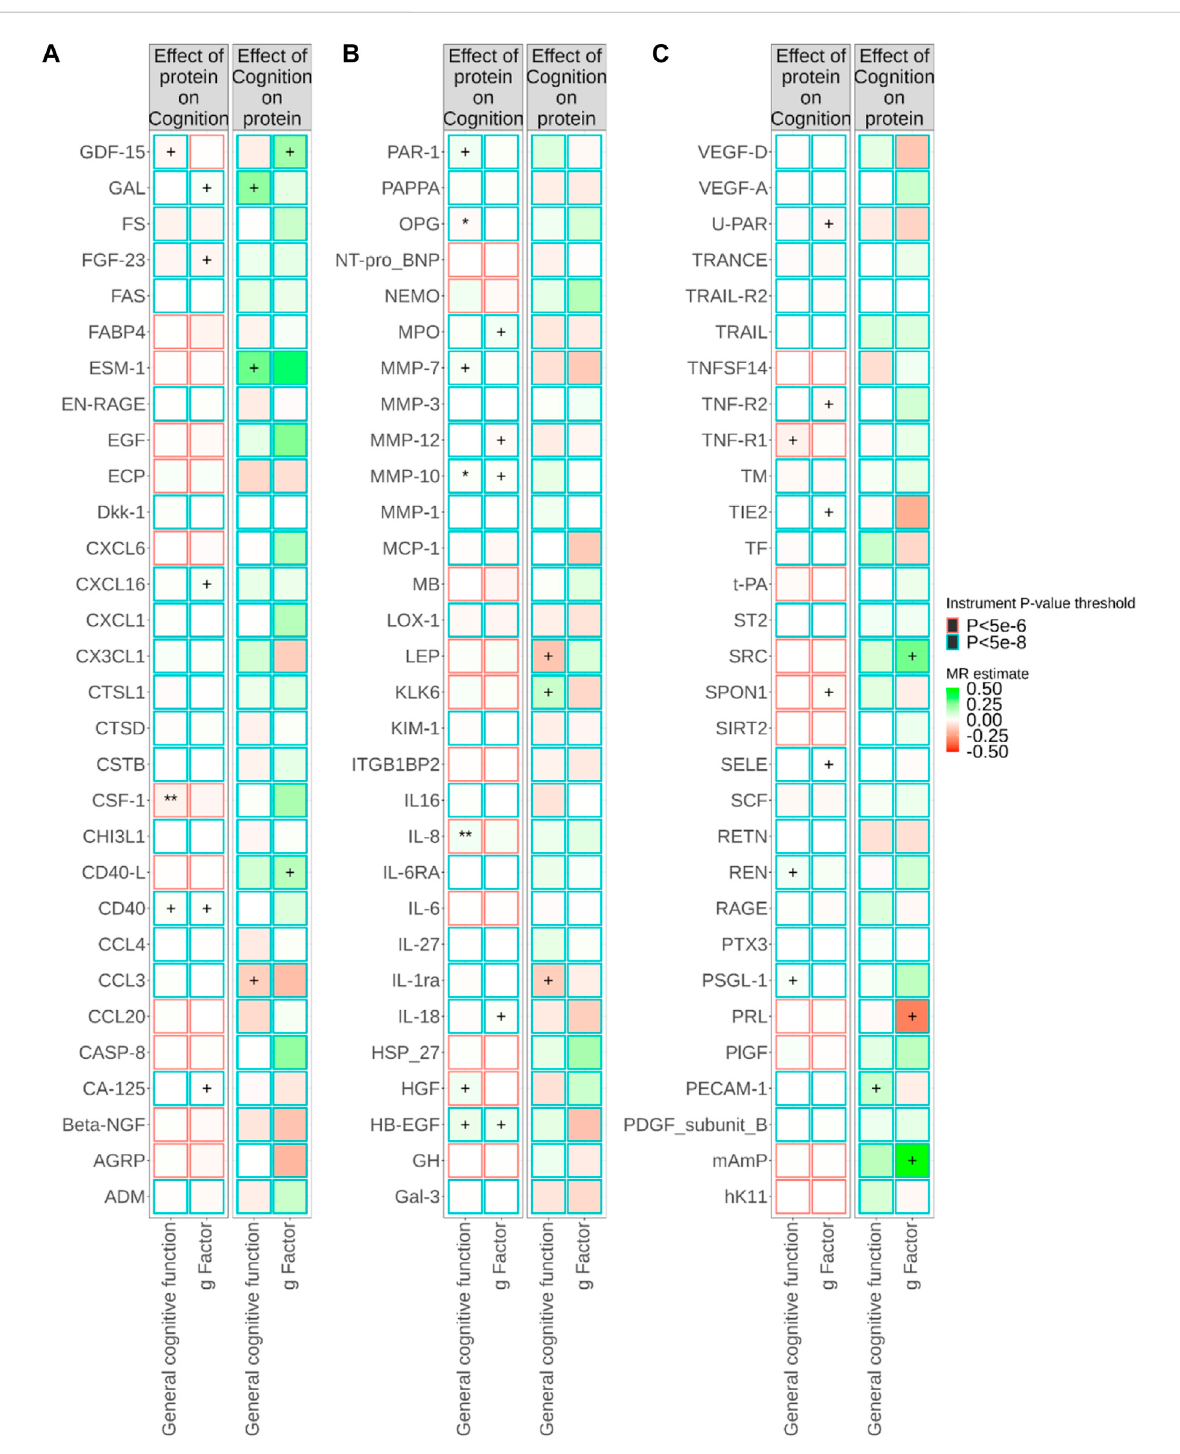
FIGURE 1 Relationships between plasma protein concentrations and cognitive traits from bidirectional Mendelian randomisation (MR). MR estimate was obtainedfrominverse-varianceweighted(IVW)method.Thesymbol+indicatesanassociationwitha p -valuesmallerthan0.05,thesymbol*indicatesan associationwitha p -valuesmallerthan0.05/90,andthesymbol**indicatesanassociationwitha p -valuesmallerthan0.05/180.Duetothelargenumber of proteins, MR results for different proteins are presented in (A – C) in this fi